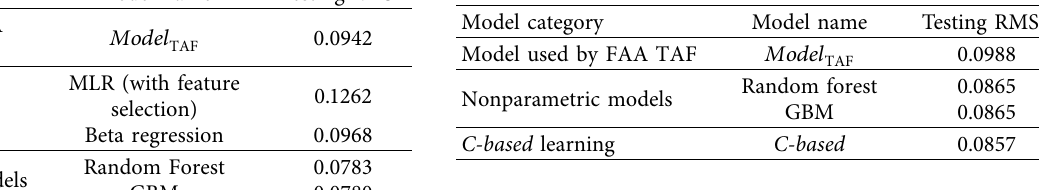
Figure 8: Importance of directShareQLag and driectShareYLag in the two selected models: (a) variable importance of directShareQLag and driectShareYLag in the GBM model for seasonal O&D category; (b) variable importance of directShareQLag and driectShareYLag in the GBM model for nonseasonal O&D category. Table 6: Model forecasting performance comparison. Table 7: Model performance comparison for forecasting of 2018